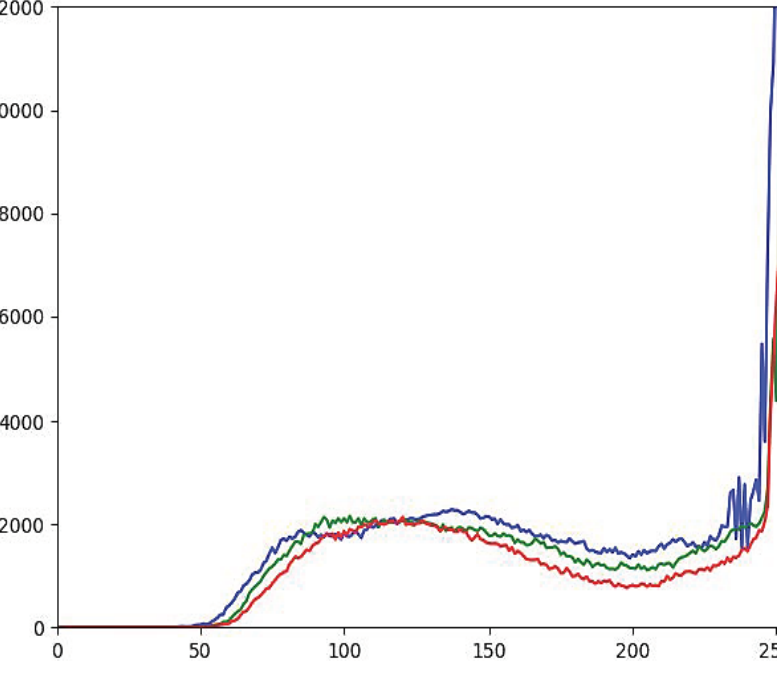
Figure 33. Histogram of the RGB graph for the image (see Figure